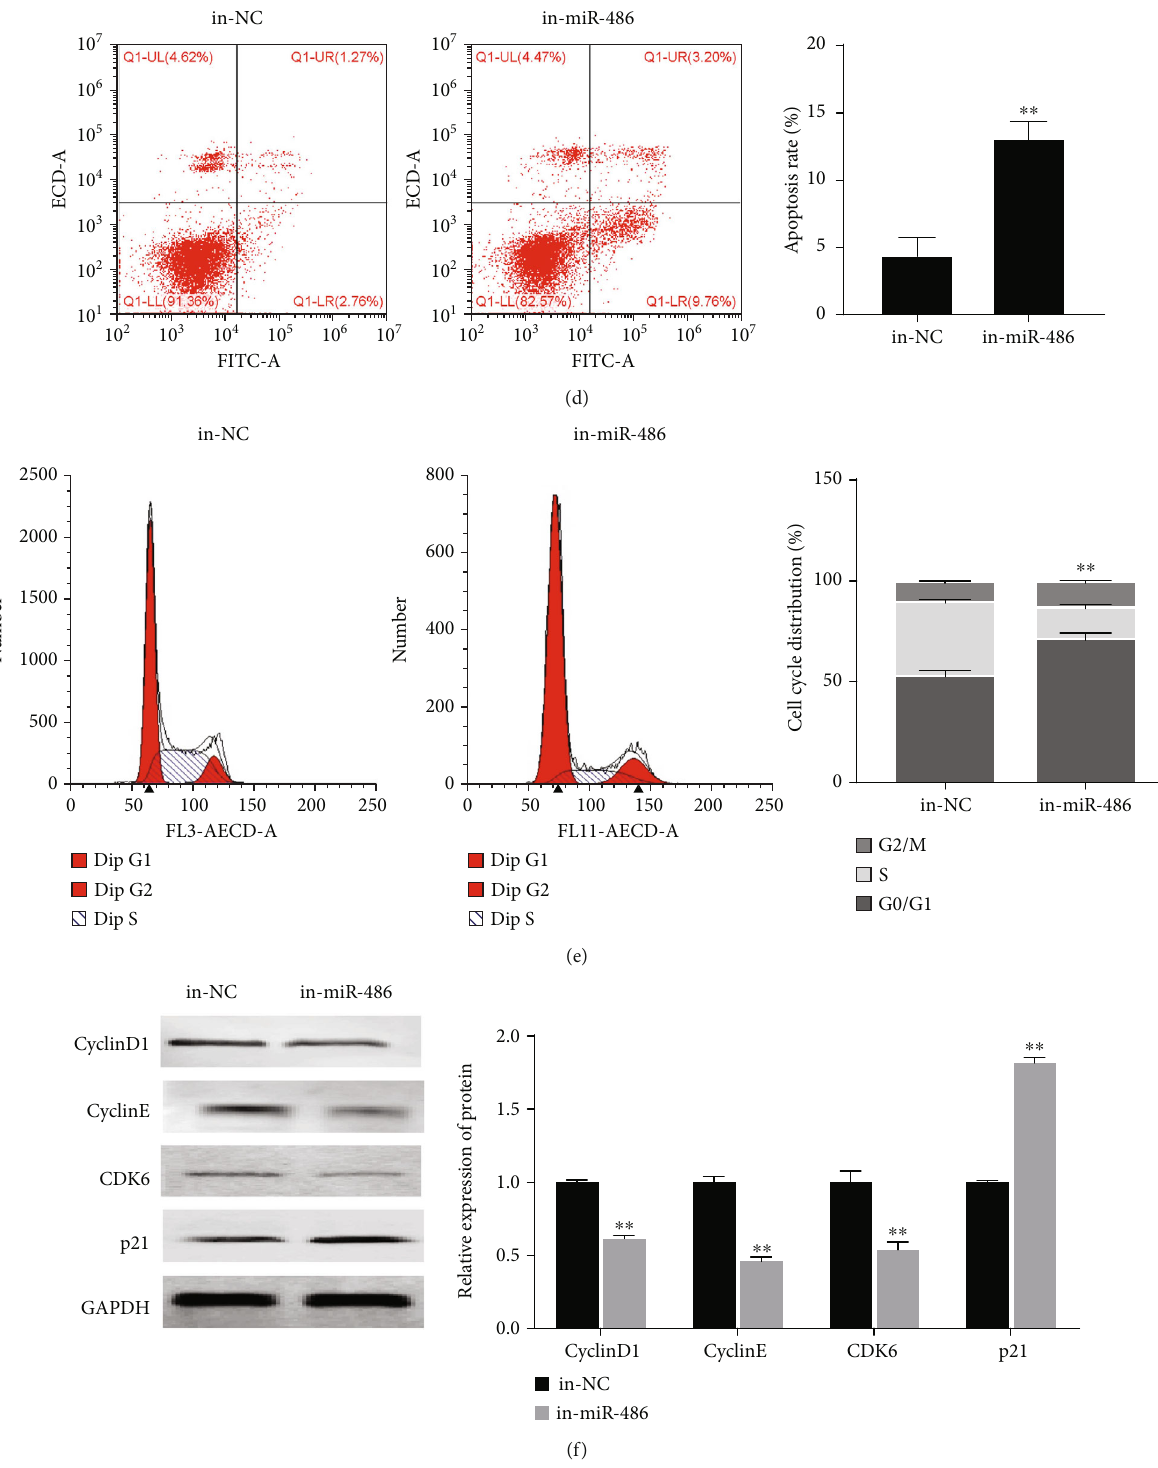
Figure 2: Interference with miR-486 expression inhibits the biological function of OC cells. (a) CCK-8 to detect the cell viability of SKOV3 after transfection with NC inhibitor and miR-486 inhibitor; (b) colony formation assay to detect the number of colonies of SKOV3 after transfection with NC inhibitor and miR-486 inhibitor; (c) Transwell assay to detect the invasion of SKOV3 after transfection with NC inhibitor and miR-486 inhibitor; (d, e) FCM to detect the apoptosis and cell cycle of SKOV3 after transfection with NC inhibitor and miR-486 inhibitor; (f)Western blot to detect the expression levels of cell cycle-related proteins p21, CyclinD1, CyclinE, and CDK6. ∗ P < 0 : 05 and ∗∗ P < 0 : 01 vs. the in-NC